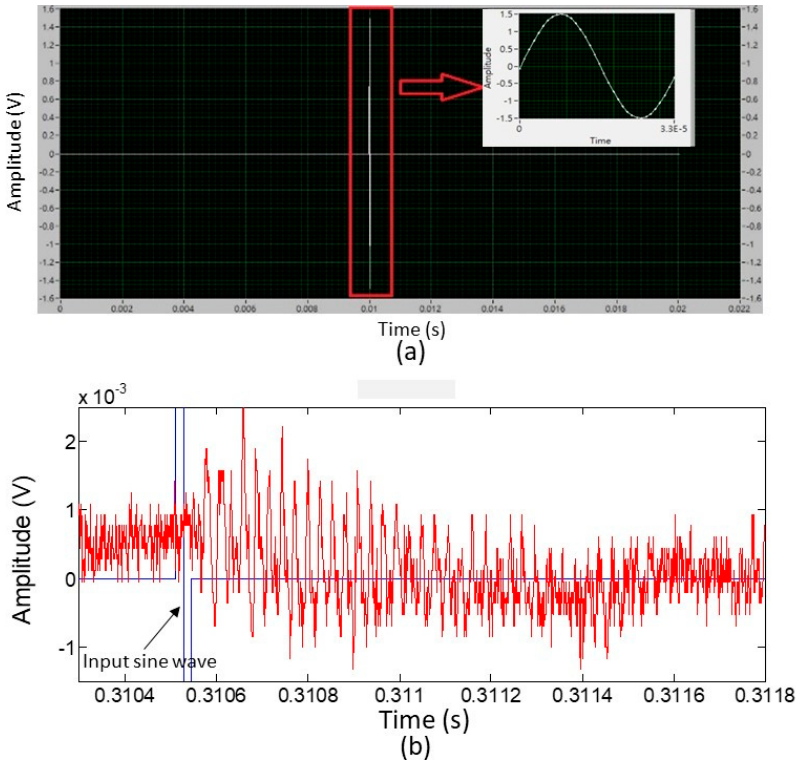
Figure 8. ( a ) The designed single waveform of the input signal to actuate the PMUT (image from the Labview software). ( b ) Acquired raw signal data from the microphone module at a distance of 10 mm away from the PMUT.